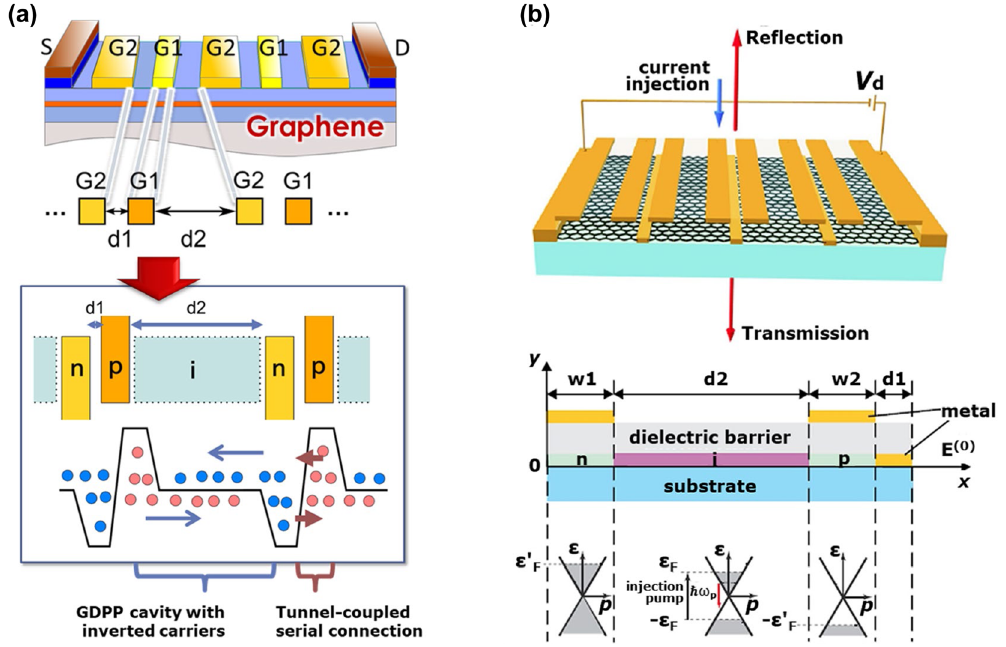
Figure 5: Implementations of the plasmonic THz laser cavities using DGG-GFET structures. (a) Primitiveplasmonic THz laser cavity in an asymmetric DGG-GFETstructure. The wider d2-spacing ungated region works for the GDPP